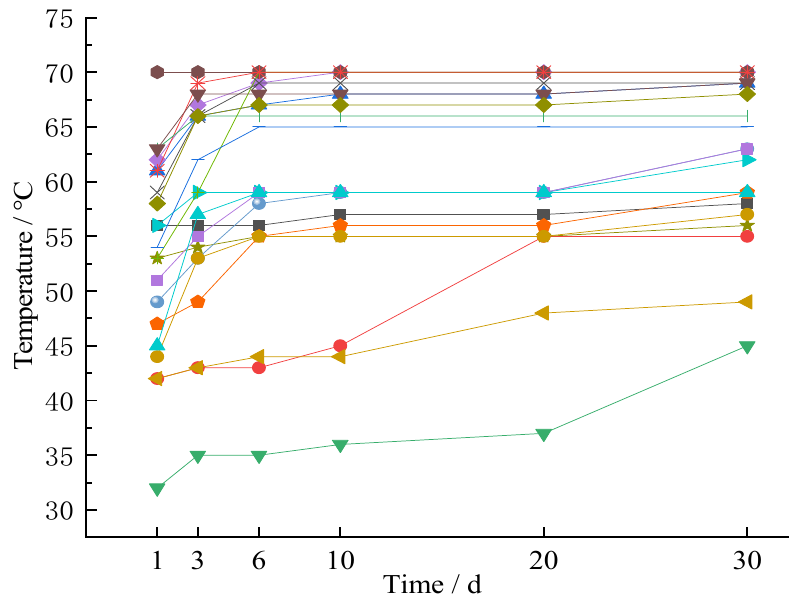
Figure 12. Monitoring results of internal temperature of gangue hill after fire-extinguishing.